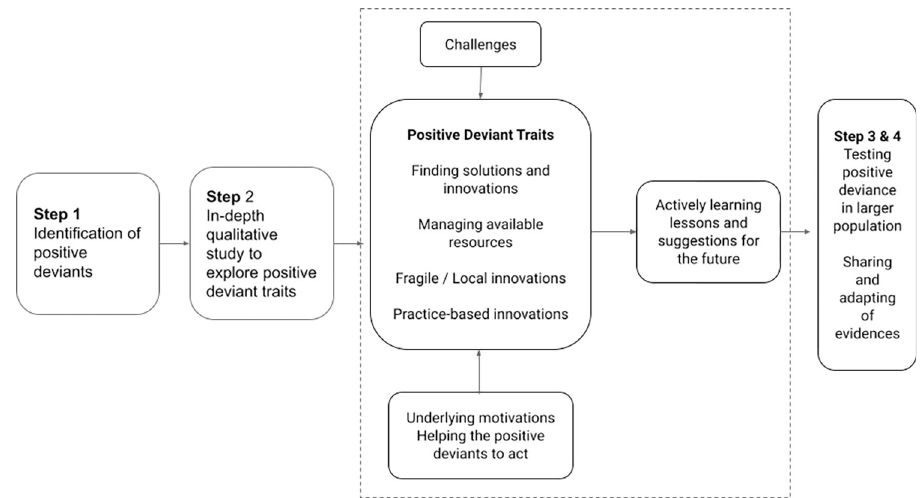
Fig 1. The flow of the study based on the steps of the positive deviance